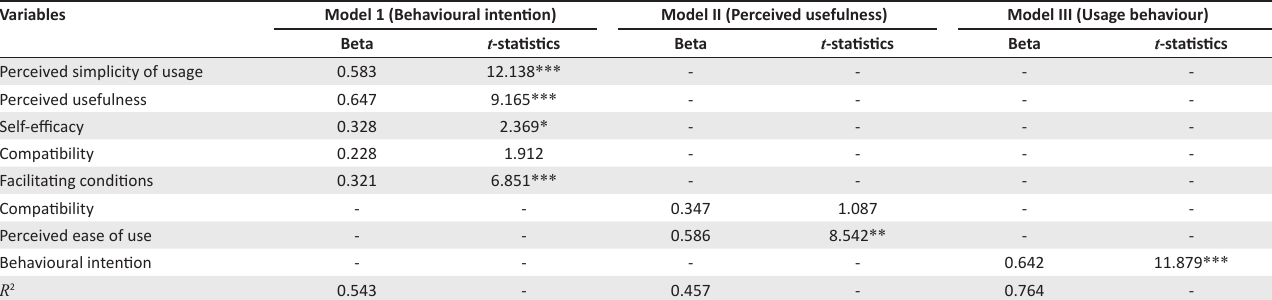
TABLE 5: Regression outcome.